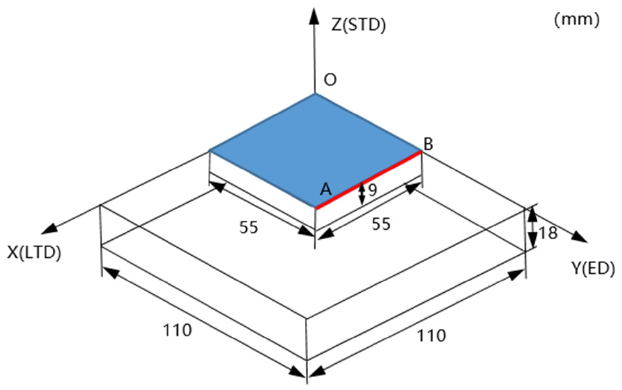
Figure 2. A schematic showing the dimension of the sample for quenching treatment (white) and simulation (blue) and RS measurement path (red line).